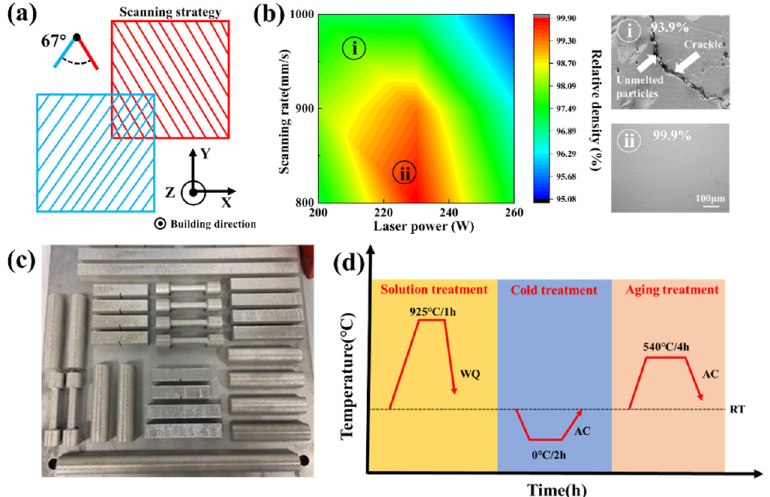
Figure 2. ( a ) Scanning strategy of the SLM forming process; ( b ) comparison of the density of the printed matter for different SLM forming parameters; ( c ) physical drawing of the SLM-formed parts; ( d ) heat treatment of the SLM-formed parts. Table 2. SLM forming process parameters. Laser